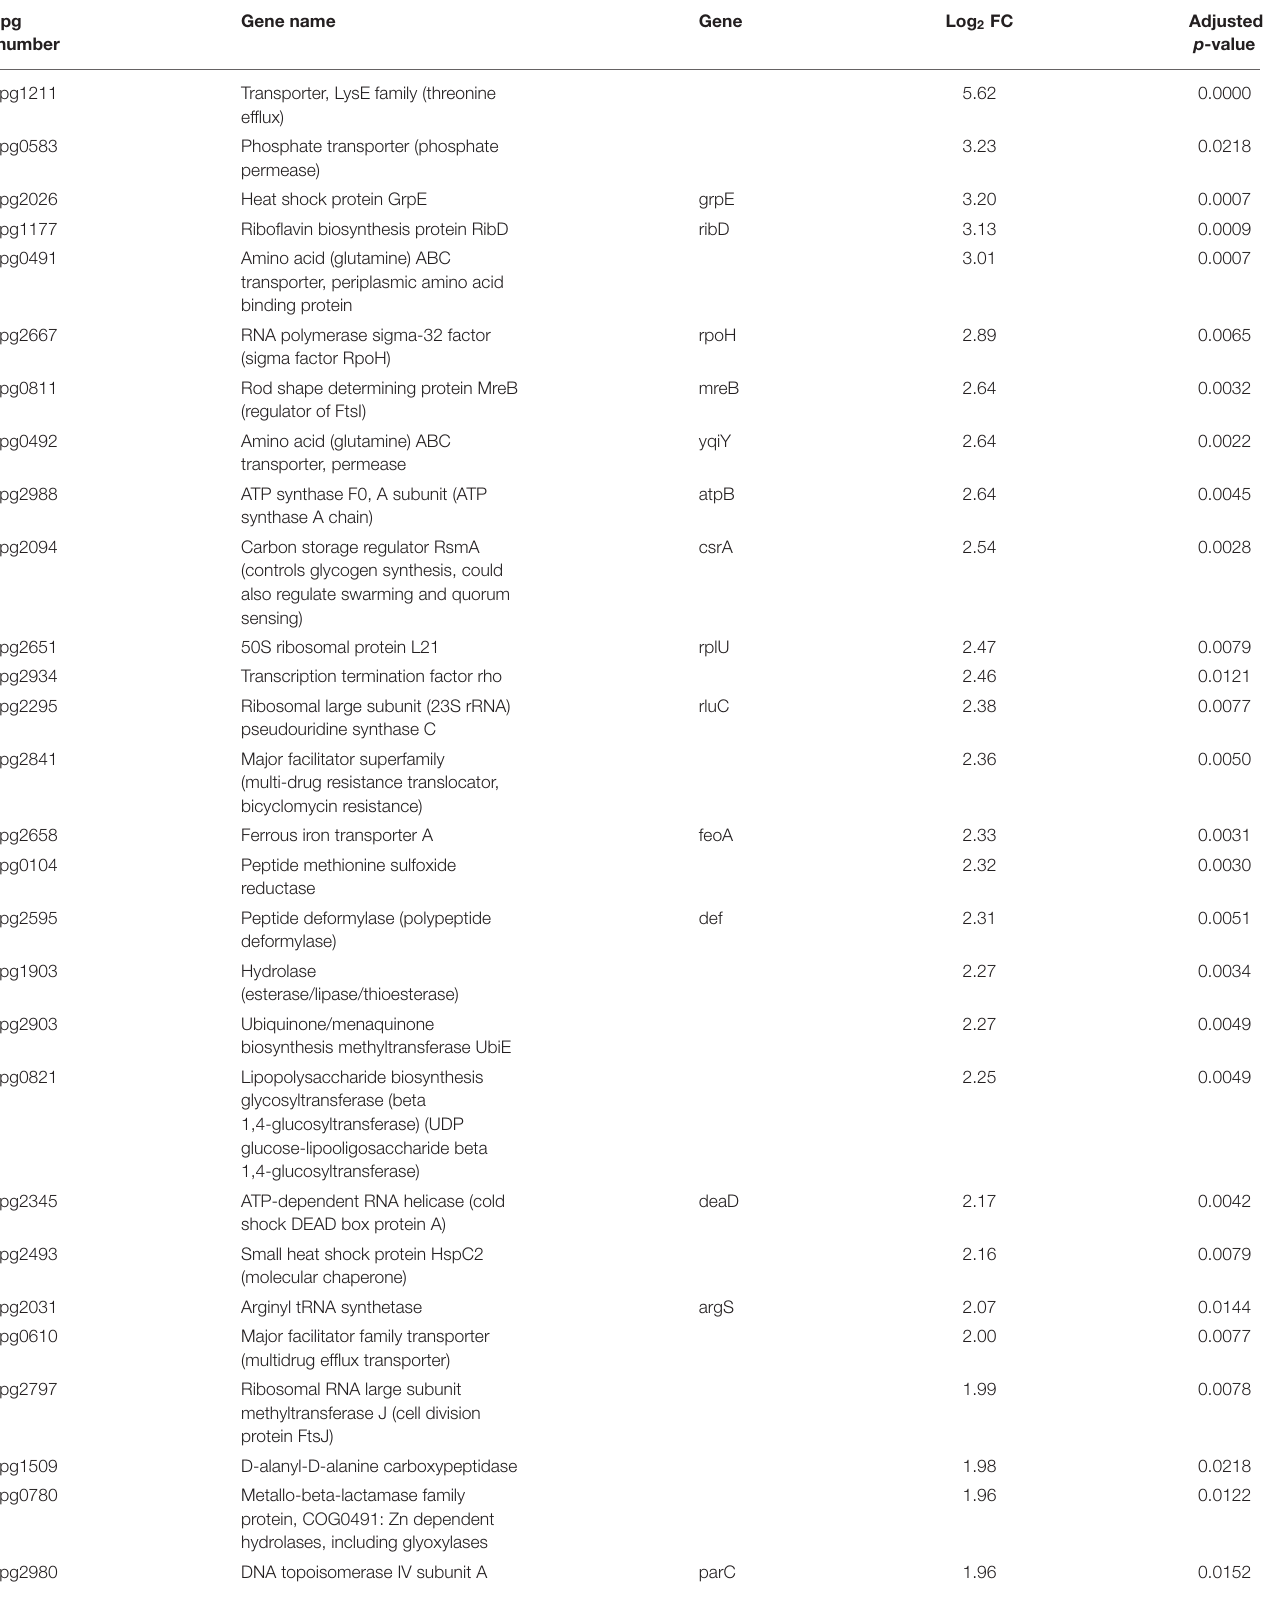
TABLE 4 | Selected upregulated genes identified by